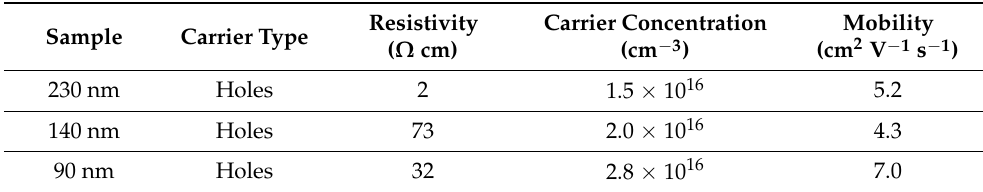
Table 1. Summary of the main parameters extracted by Van der Pauw and Hall effect measurements at room temperature.